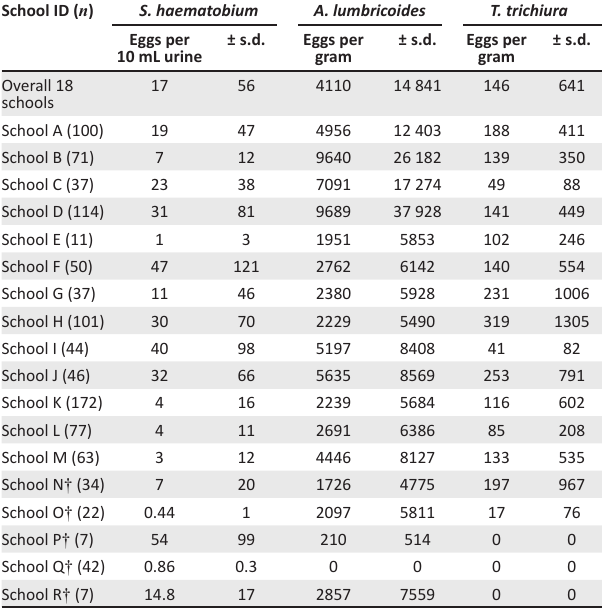
TABLE 1: Prevalence and intensity of Schistosoma haematobium per number of urine samples collected per study subject. Number of urine samples collected